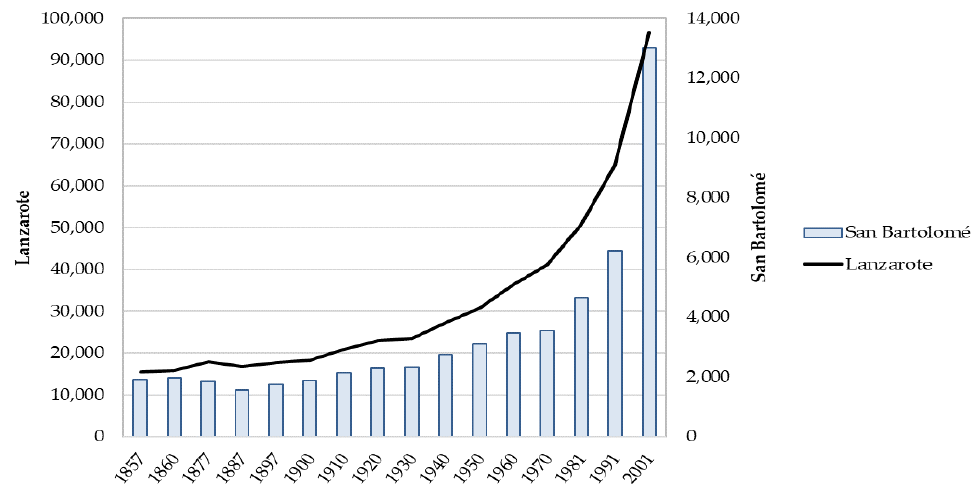
Figure 2. Evolution of the population in the municipality of SB and Lanzarote, 1857–2020.Source: own work from INE data.